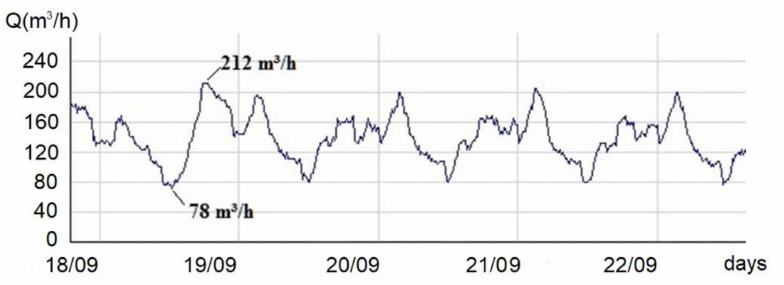
Figure 10. Detail of the maximum fluctuation of the flows measured in the PRV pipeline during the month of September (reference month; +1% over the year